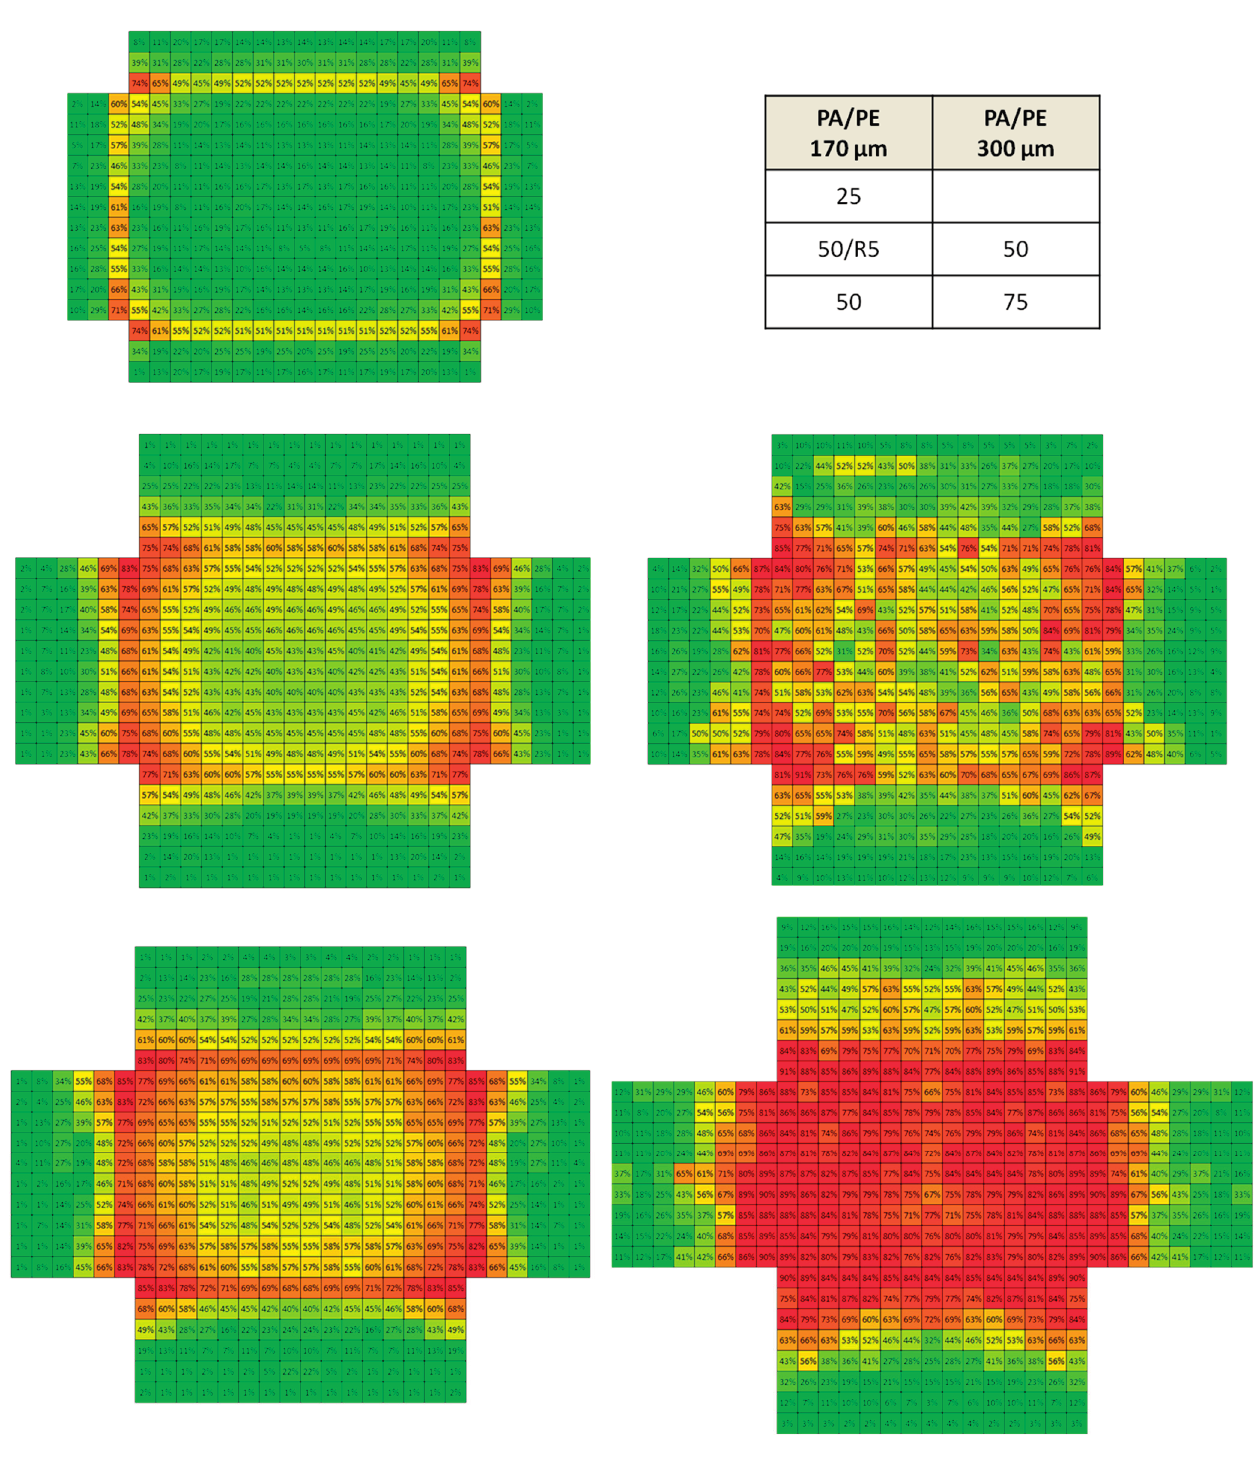
Figure 4. Visual representation of percentage thinning in 25-, 50/R5-, 50-, and 75-trays of the thin ( left ) and thicker ( right ) PA/PE